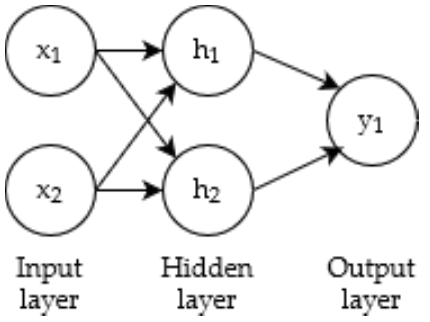
Figure 4. An example of a fully connected feed forward network with two input neurons, two neurons in the hidden layer, and one output neuron.